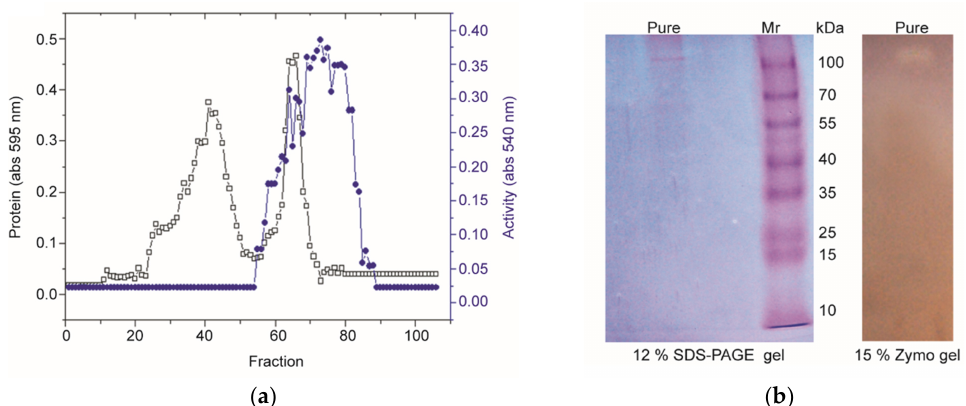
Figure 2. ( a ) The elution profile of PN32 from the Sepharose CL 6B permeation column (1.5 × 30 cm); ( b ) SDS-PAGE and zymography of purified PN32. Lane M: Protein molecular weight marker; lane pure: Purified PN32 after chromatographic separation by the Sepharose CL 6B column.